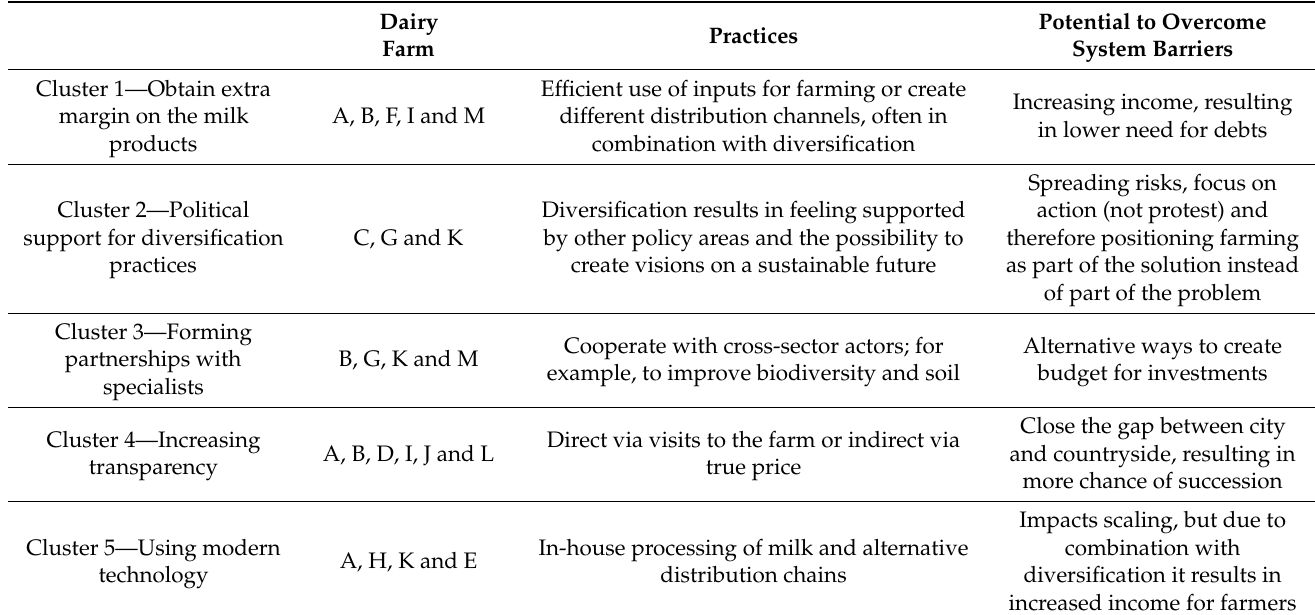
Table 2. Clusters, practices and potential to overcome system